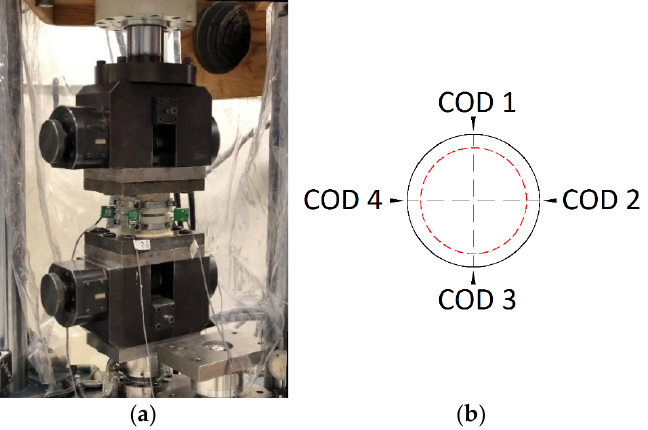
Figure 2. ( a ) Loading arrangement and ( b ) plane view of the sensor locations.